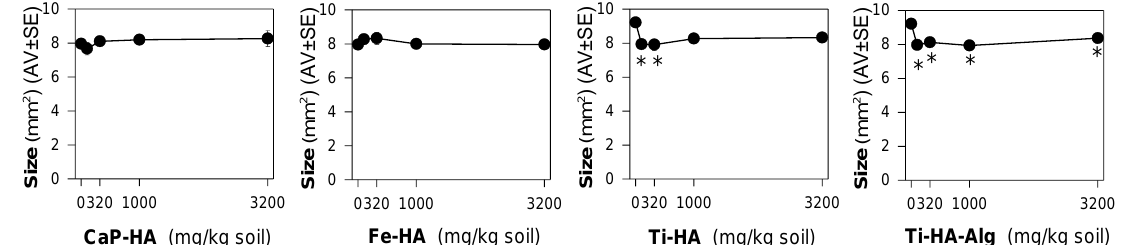
ard extension), and ( C ) overview of the time series sampling at days: 7, 14, 21, 28 and 56 days. Values represent number of adults, juveniles, and population as average ± standard error (AV ± SE). *: p < 0.05 (Dunnett ’ s method).